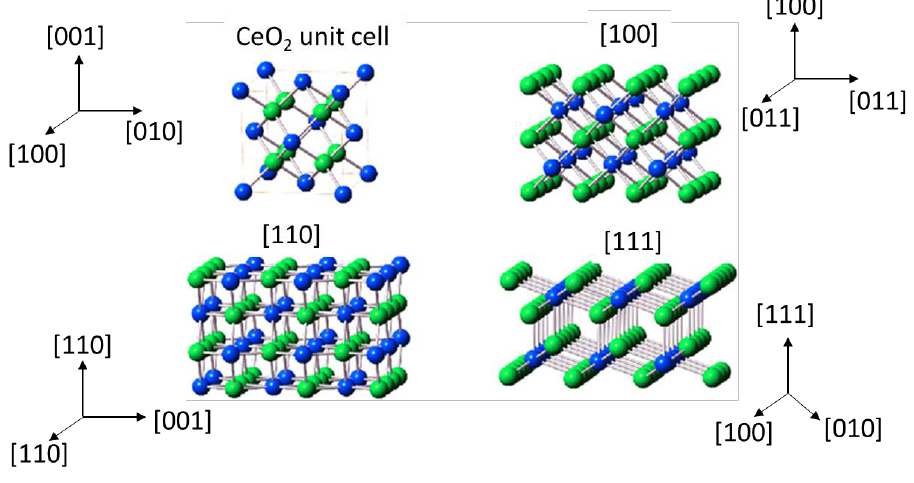
Figure 1. Crystal models of cerium dioxide shapes